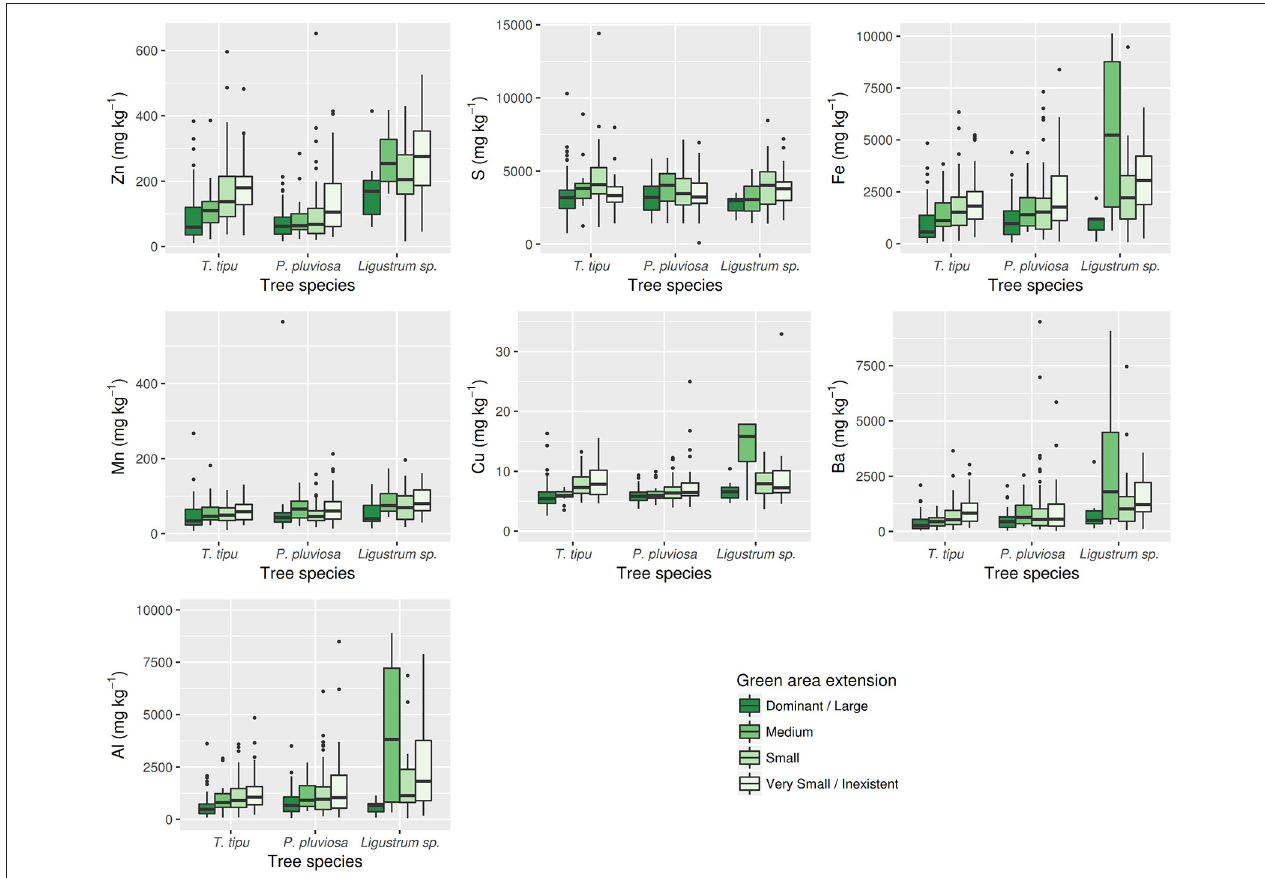
FIGURE 5 | Boxplots of elemental concentration on tree barks of Tipuana tipu, Poincianella pluviosa , and Ligustrum sp. by different green areas extension: Dominant/Large, Medium, Small, Very